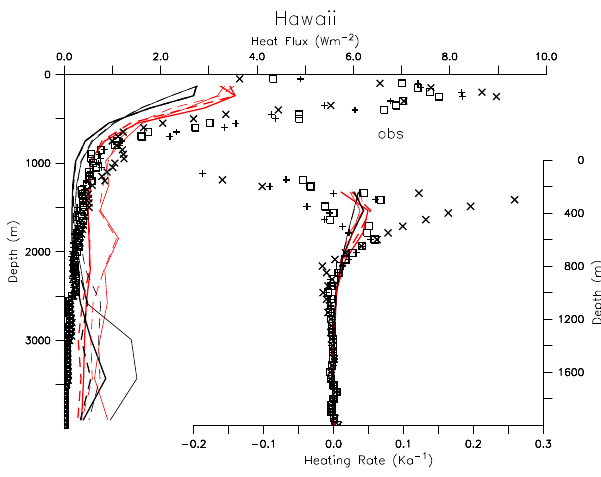
Fig. 10. As Fig. 9 but for the heat flux and heat flux